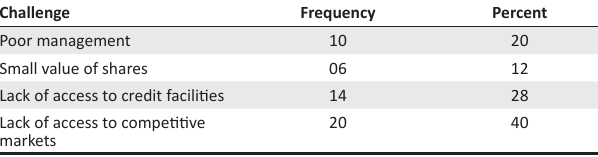
TABLE 4: Challenges for cooperatives in sustaining